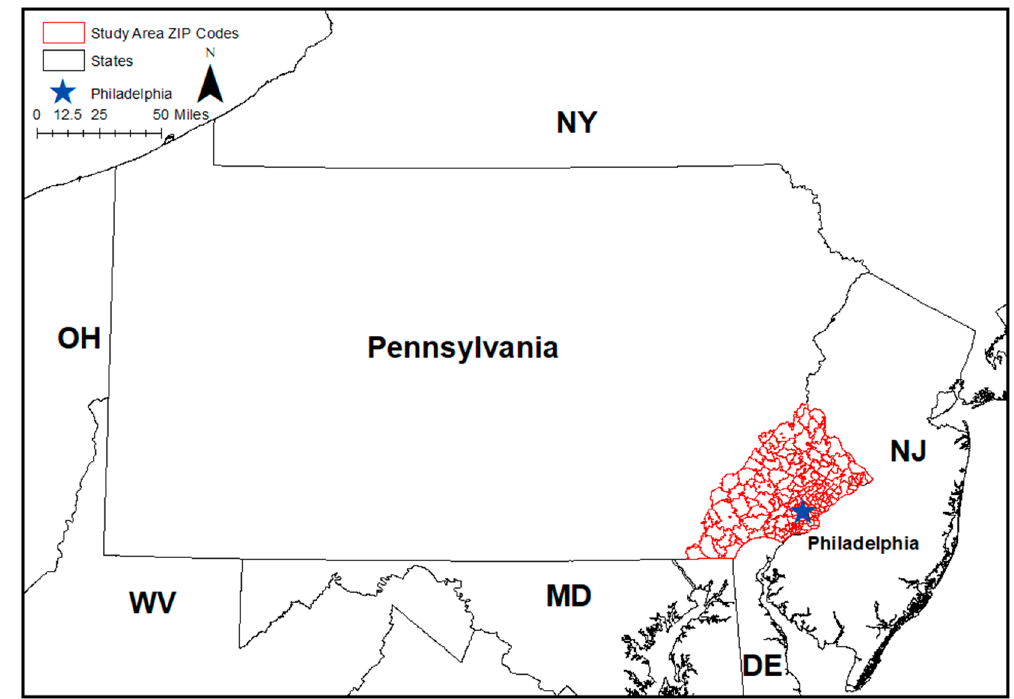
Figure 1. The study area in southeastern Pennsylvania. (NJ: New Jersey, DE: Delaware, MD: Maryland, WV: West Virginia, OH: Ohio, NY: New York).